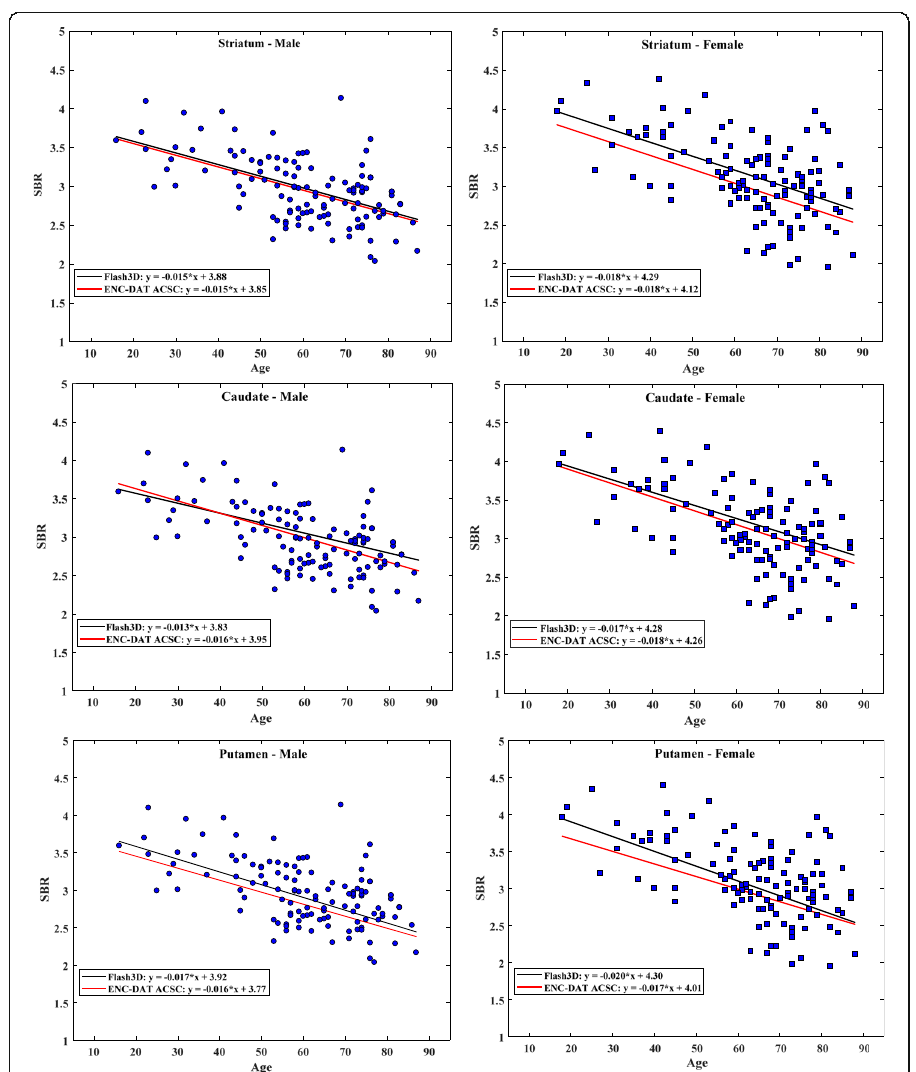
Fig. 5 Comparison between SBR values from Flash3D database with values from the ENC-DAT study using BRASS analysis of uncalibrated attenuation and scatter corrected scans (ENC-DAT-ACSC), according to gender